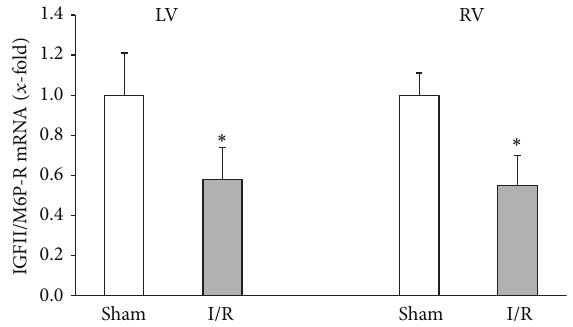
Figure2:IGFII/M6PreceptormRNAexpressionintheleftventricle (LV) and right ventricle (RV) of rat hearts that underwent sham surgery or 30min ischemia (ligation of the left arteria descendens) and one day of reperfusion (I/R). Data are means ± SD from 𝑛 = 8 hearts. mRNA expression was quantified by real-time RT-PCR and expression is normalized to beta-2-macroglobulin (b2M). ∗ 𝑃 < 0.05 versus sham (unpublished